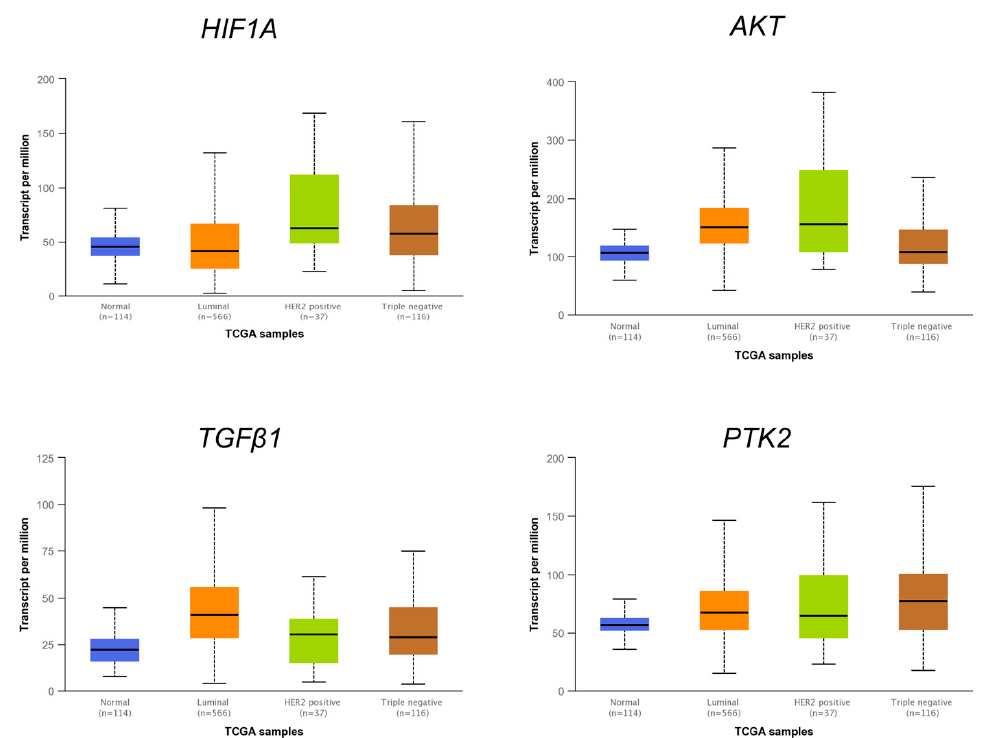
Figure 8. Expression of HIF1A , AKT , TGFB1 , and PTK2 mRNAs in biopsies from breast cancer tumor subtypes according to TGCA databases. Bar graph showing expression levels of the four mRNAs predicted as targets for the miRNAs downregulated in Hs578T 3D cultures. Y -axis shows transcripts per million according to RNAseq analysis deposited on TCGA. X -axis indicates the expression in breast cancer subtypes (Luminal n = 566, HER2-positive n = 37, triple negative n = 116) compared to normal ( n = 114).